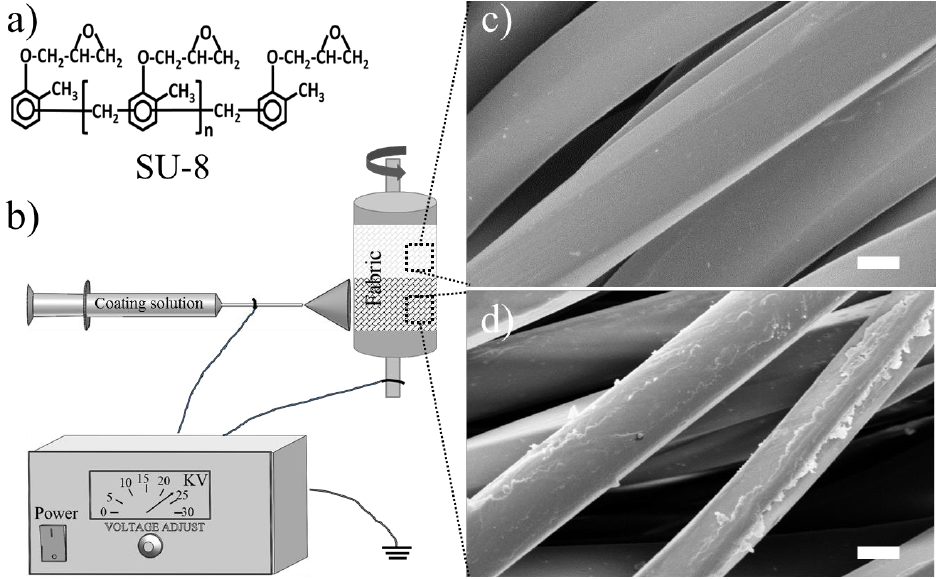
Figure 1. ( a ) Chemical structure of SU-8; ( b ) Schematic of apparatus for one-side electro-spraying treatment of fabric; ( c , d ) SEM images of the ( c ) NaOH pre-treated and ( d ) electrosprayed polyester fabric (scale bar, 10 μm).